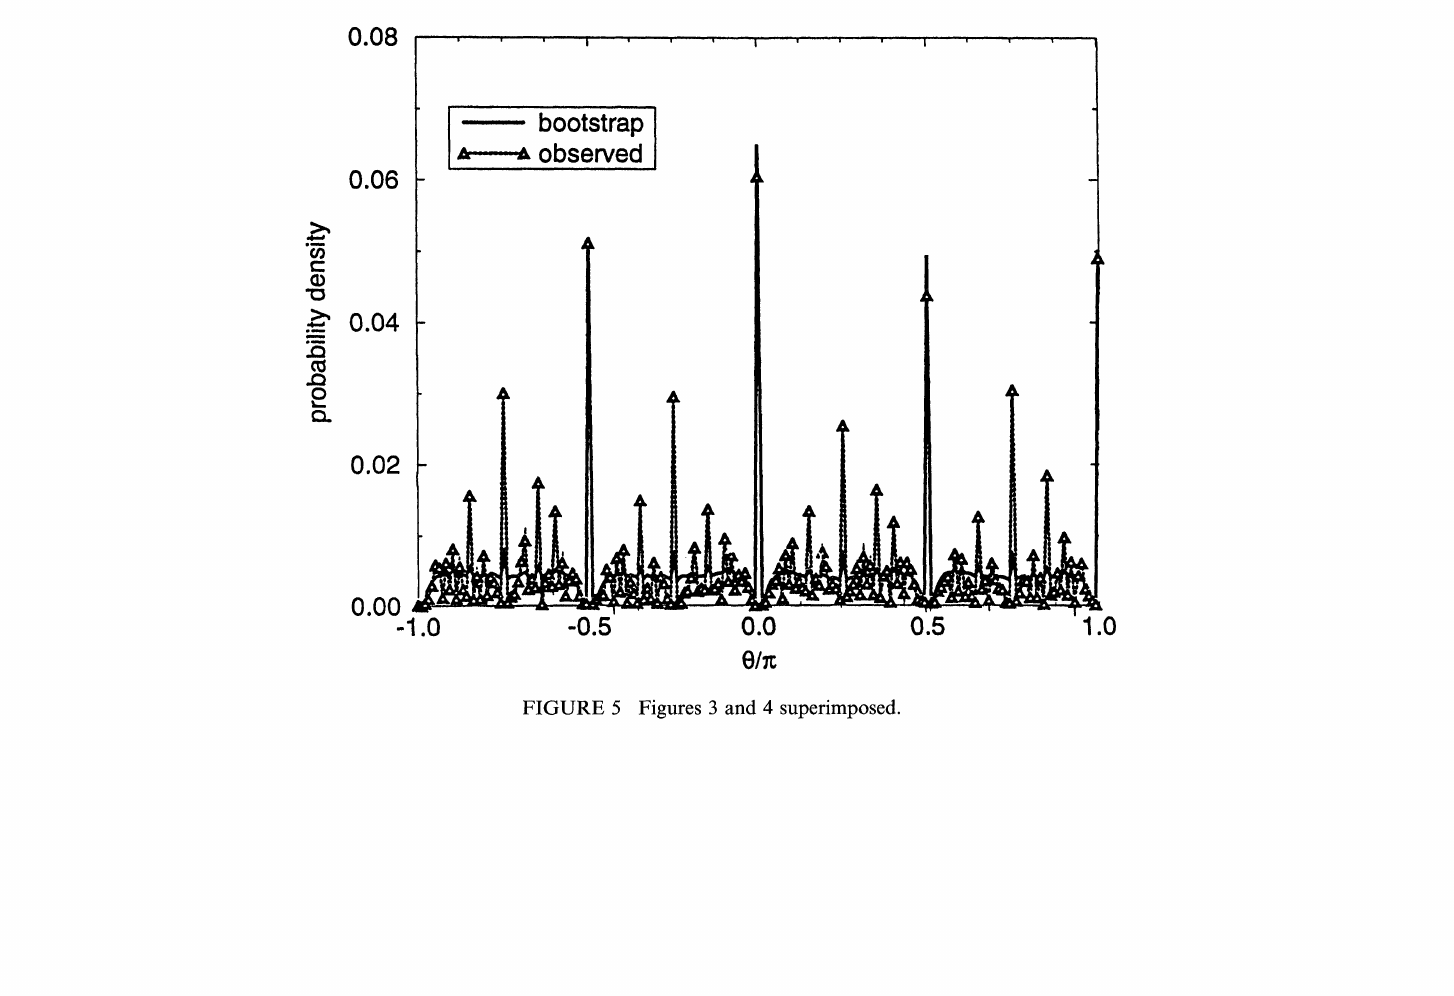
FIGURE 5 Figures 3 and 4